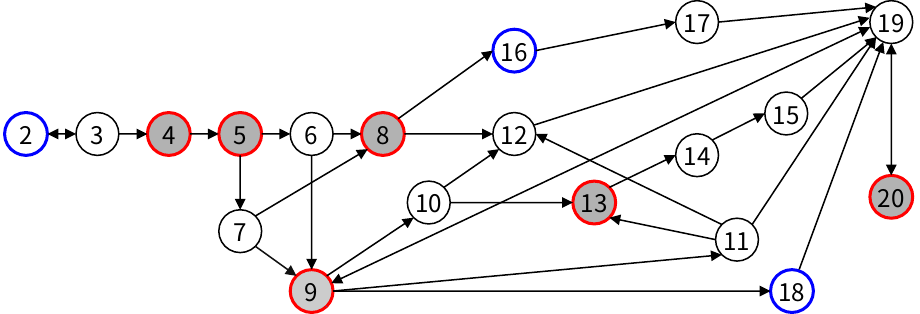
Figure 13. Reduced graph for sinus surgical navigation